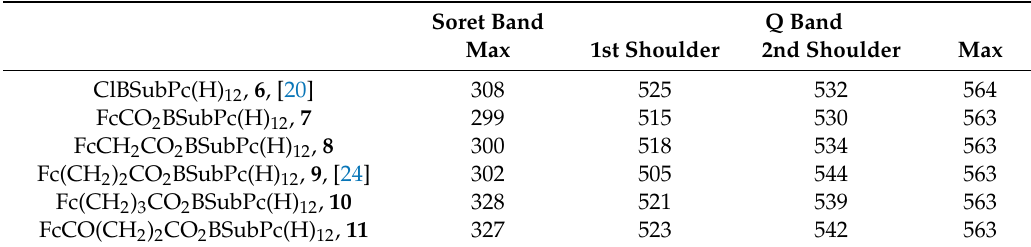
/ vis data of SubPcs 6 – 11 in tetrahydrofuran (THF). Table 1. UV/vis data of SubPcs 6 – 11 in tetrahydrofuran (THF). Table 1. UV Soret